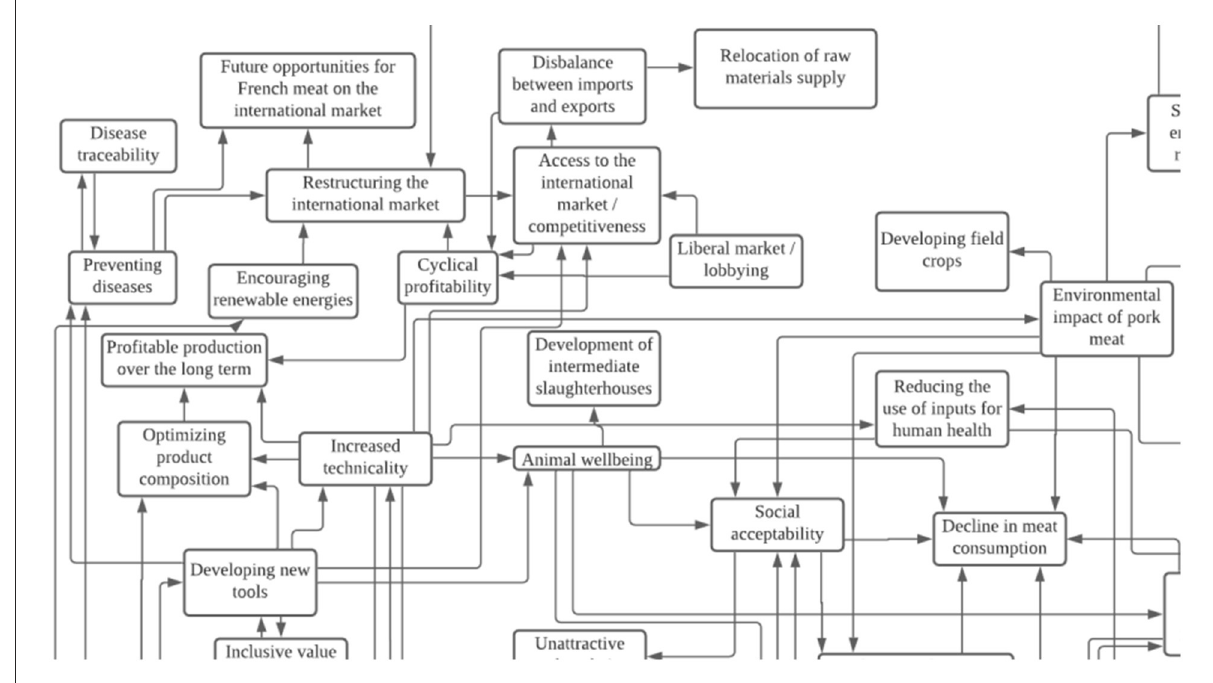
FIGURE2 Extract of a mindmap showing relations between concepts identified in an